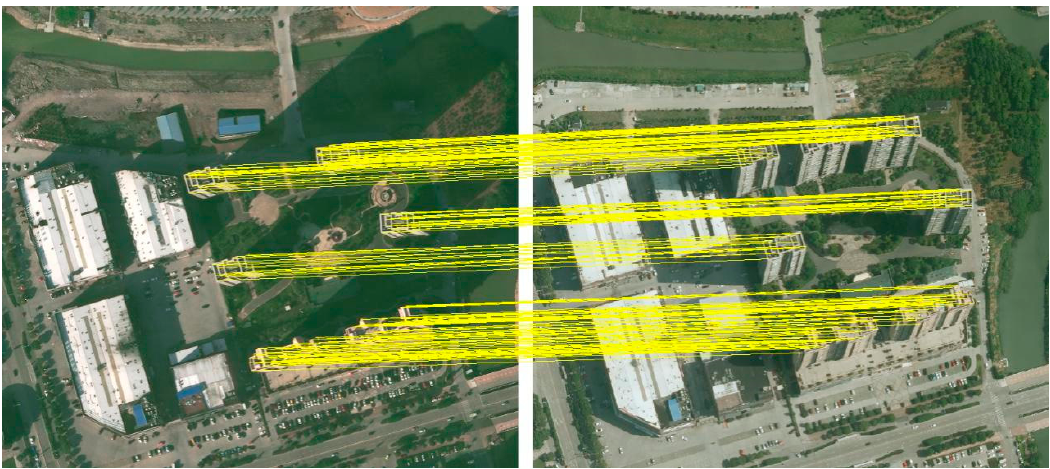
Figure 8. Results of patch-based matching using HOPC.